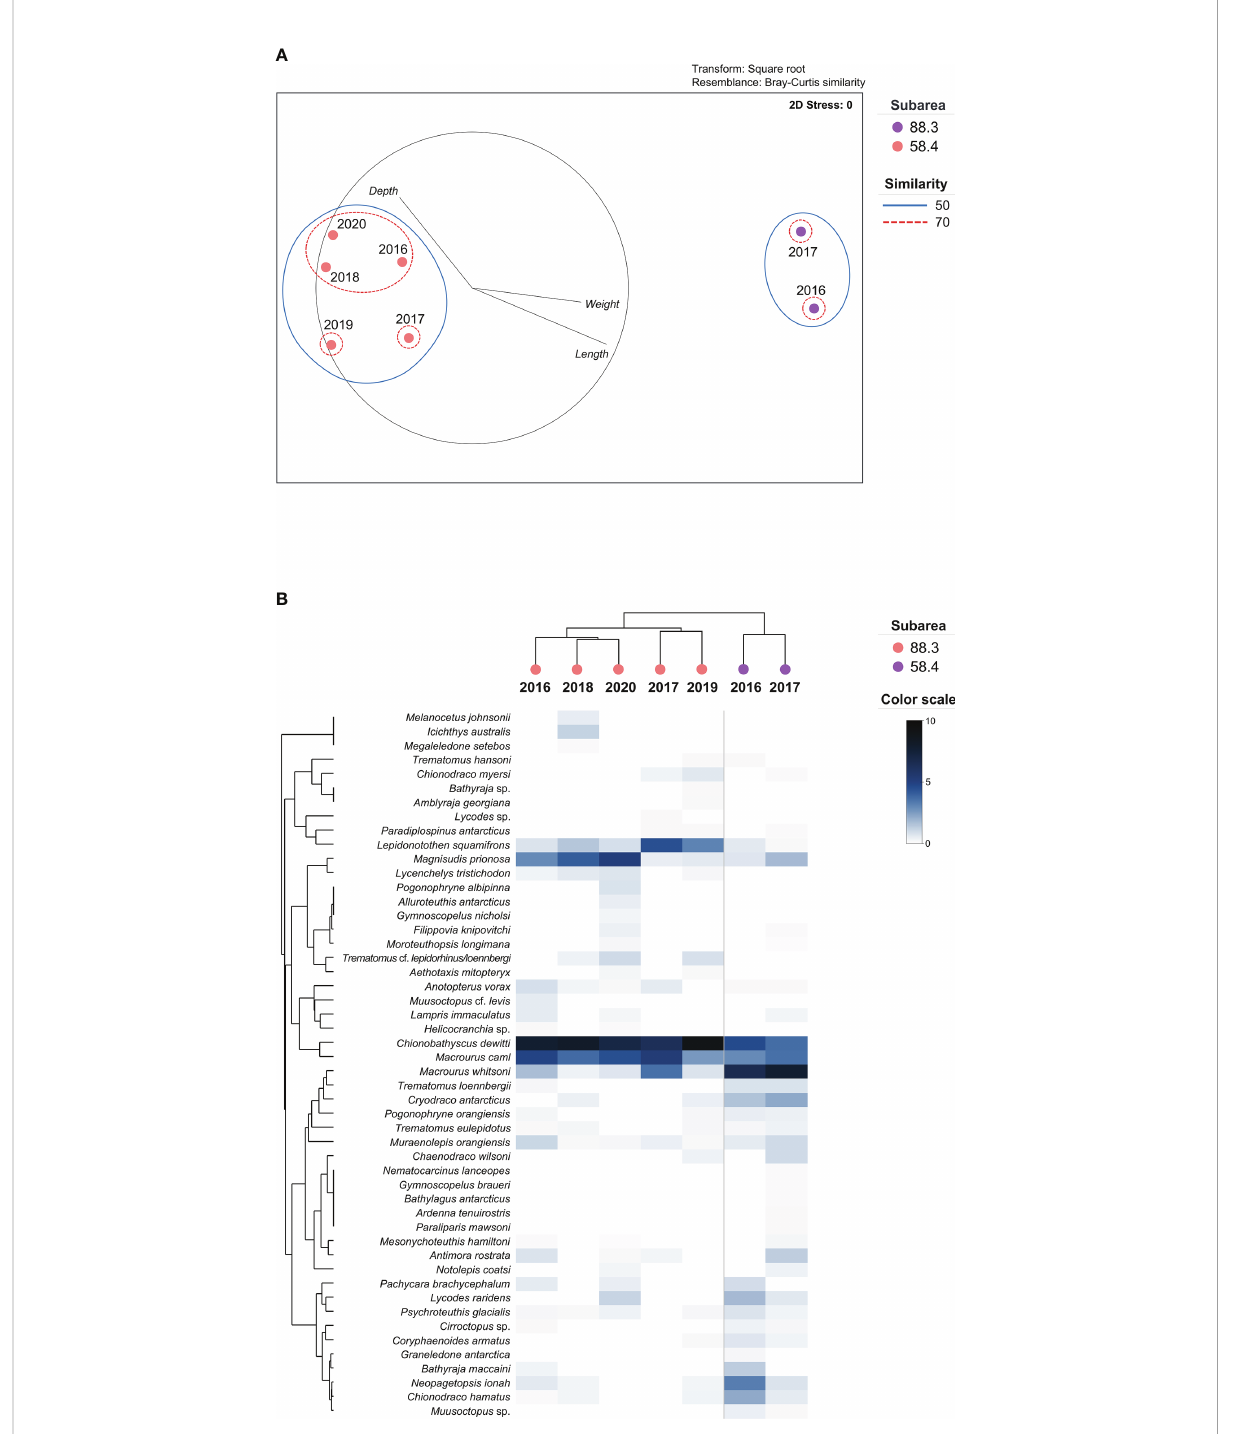
FIGURE 6 Non-metric multidimensional scaling (nMDS) plot and heatmap analyses of the prey compositions of Dissostichus mawsoni . (A) nMDS was based on Bray – Curtis similarity for the prey organism community between subareas 88.3 and 58.4. Dots represent each year in the two subareas. Blue dotted and green lines represent the hierarchical clustering similarity in the two subareas. Gray line represents the Pearson correlation between the physical parameters of each subarea. (B) Heatmap was based on the relative read abundance of prey organisms for each year, and a row dendrogram was generated using a hierarchical cluster based on Bray – Curtis similarity. The column dendrogram was based on cluster analysis of each species via cophenetic